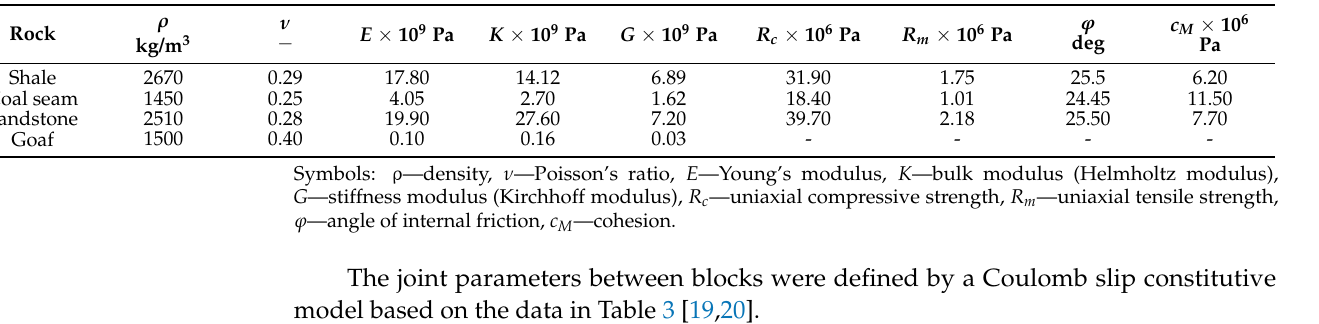
Table 2. Mechanical parameters of rocks and goaf adopted for calculations.